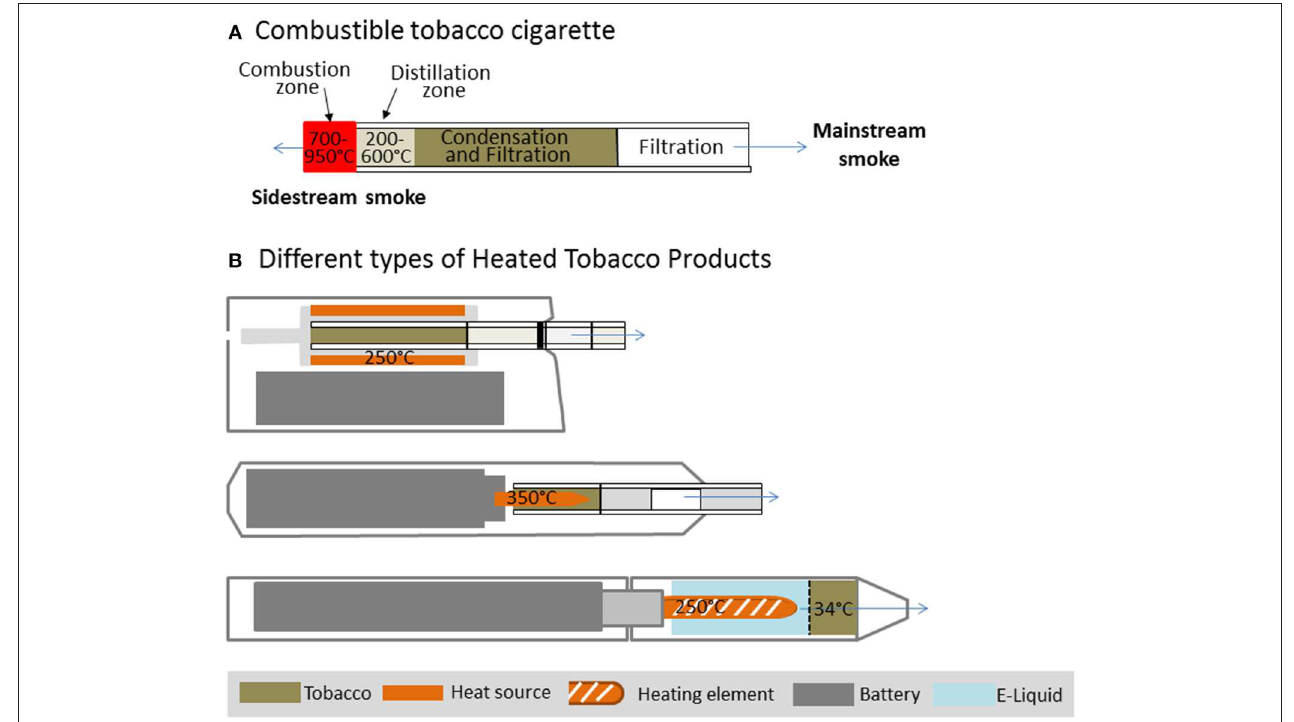
FIGURE 1 | Temperature zones in a combustible cigarette (A) in comparison to different Heated Tobacco Products (B)